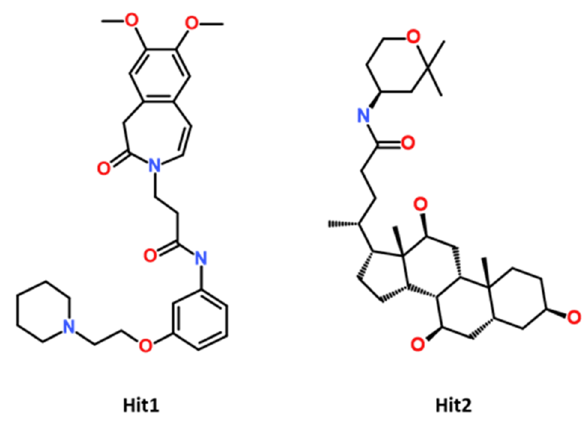
Figure 5. The 2D chemical structure of identified potential hits.